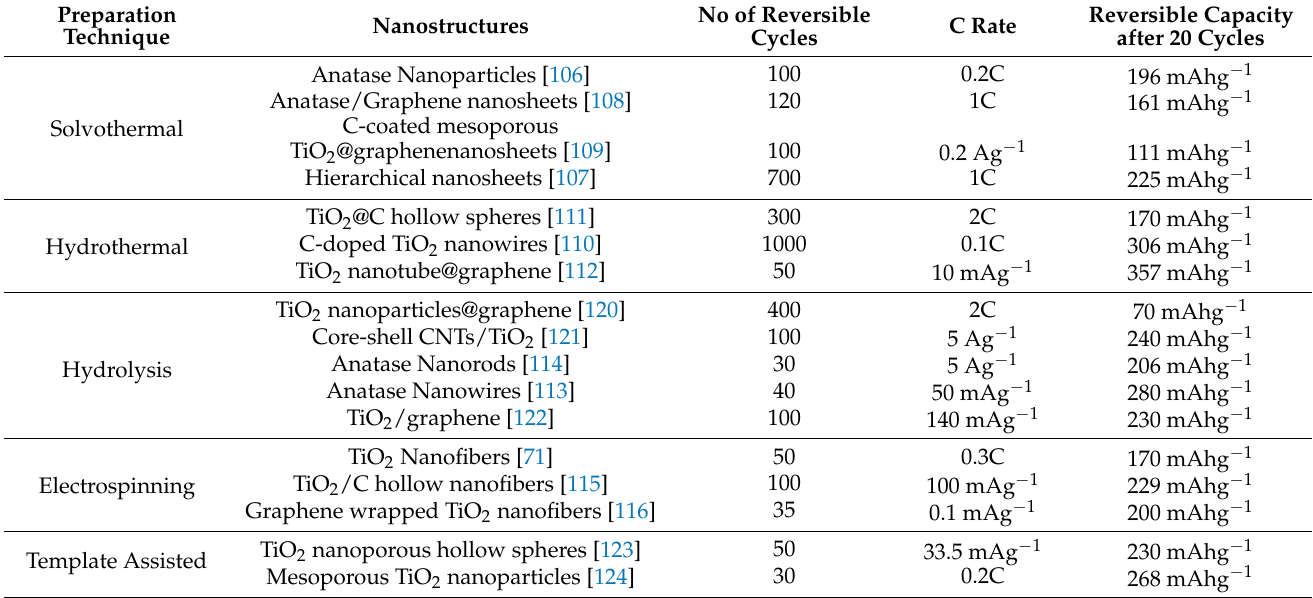
Table 1. Different TiO 2 nanostructures and their electrochemical